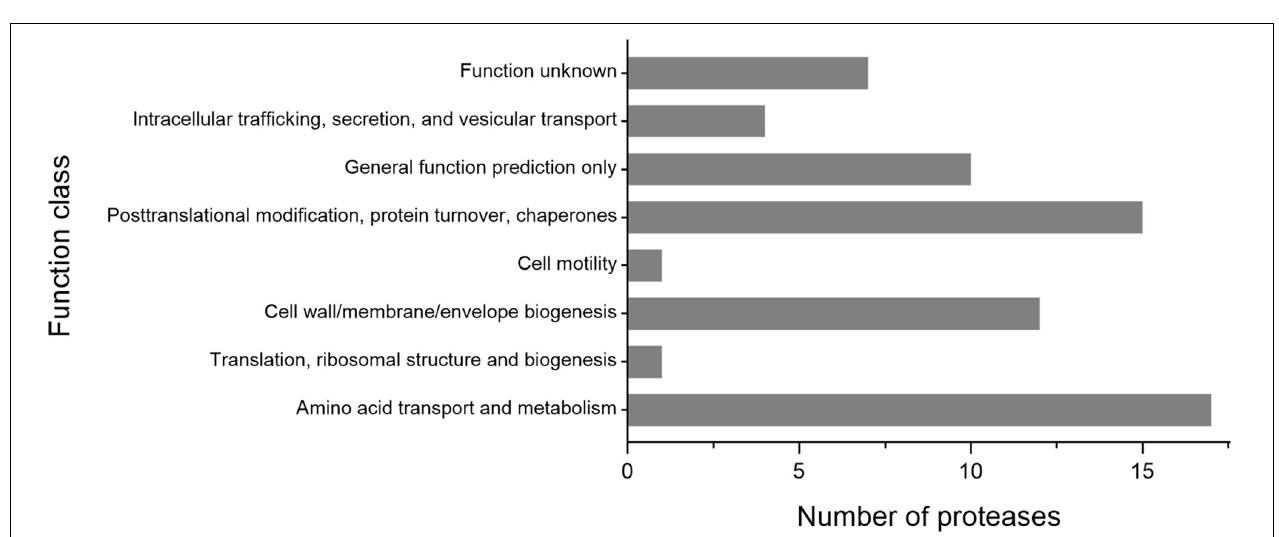
FIGURE 4 | KEGG pathway classification of proteins of strain 1A02591. The asterisk represents proteases involved in a certain KEGG pathway.